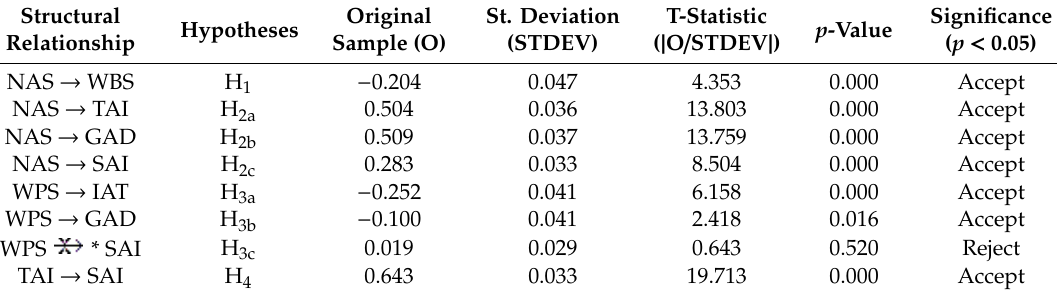
Table 13. Values between latent variables of the PANAS-GAD-7-IDATE model.